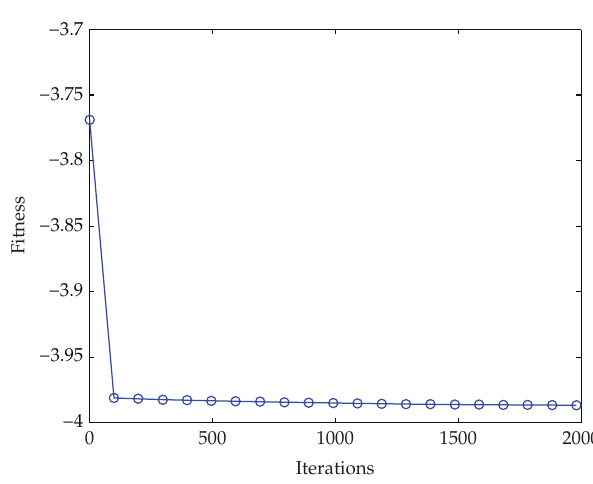
Figure 9: The average fitness values obtained with